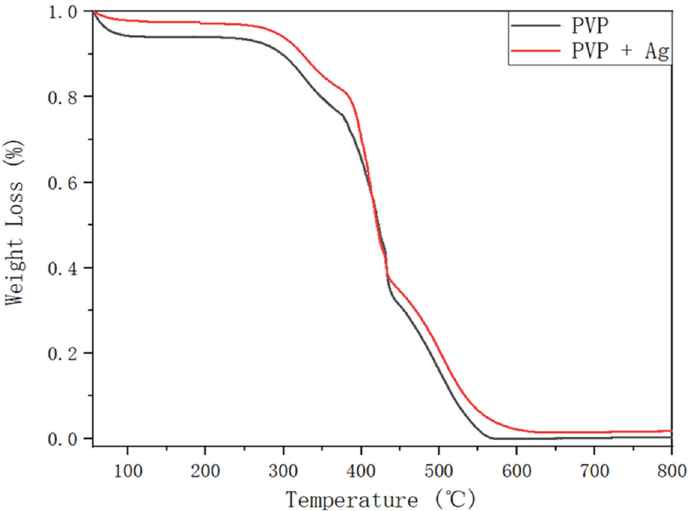
Figure 11. TGA curves of the pure PVP fibers and of the PVP/Ag NP composite fibers electrospun at 5 MPa and applied voltage of 15 kV.